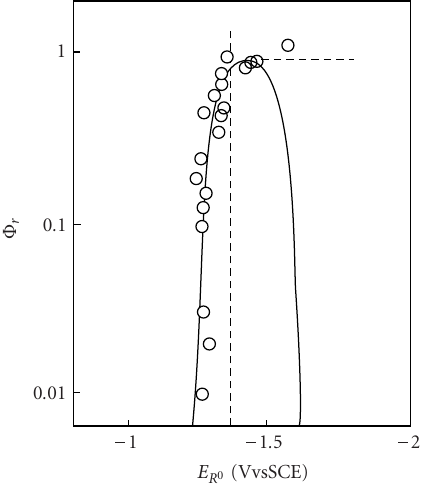
Figure 4: Quantum yield Φ r of the electron transfer to silver bro- mide grains in dye sensitization as a function of its energy gap be- tween the LUMO level of a dye and the bottom of the conduction band of silver bromide. The reduction potential of a dye ( E R 0 ) on the abscissa is used to indicate the relative height of LUMO of the dye on the basis of the linear relationship between them [2]. The solid line is derived from the Marcus theory with rearrangement energy of 0 . 05